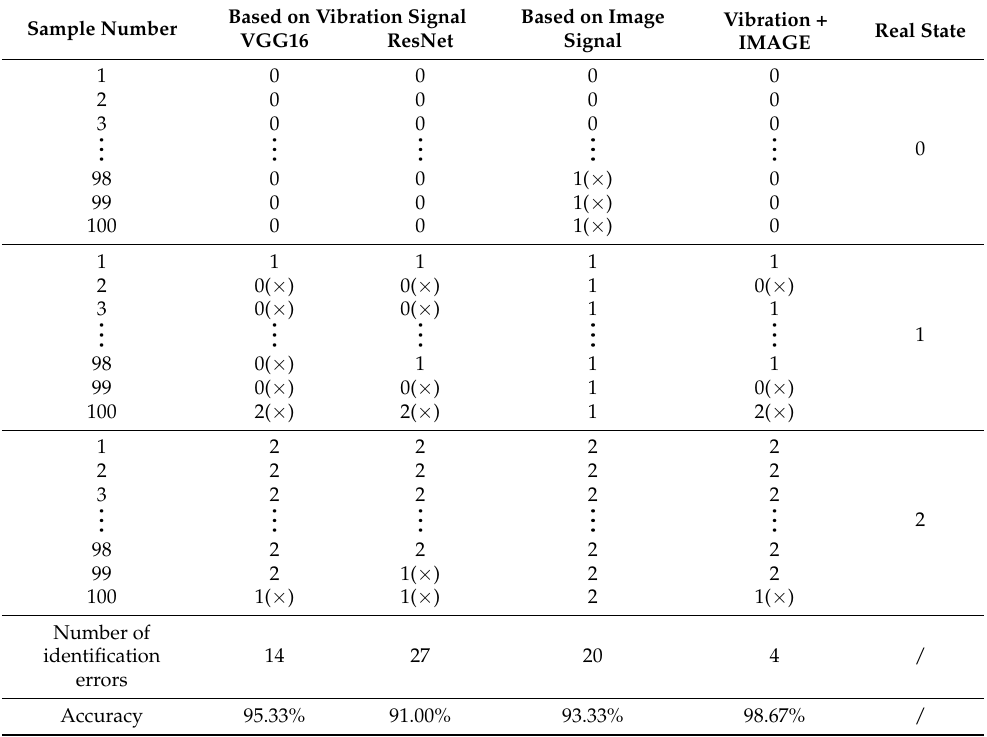
Table 13. State identification results for validation set